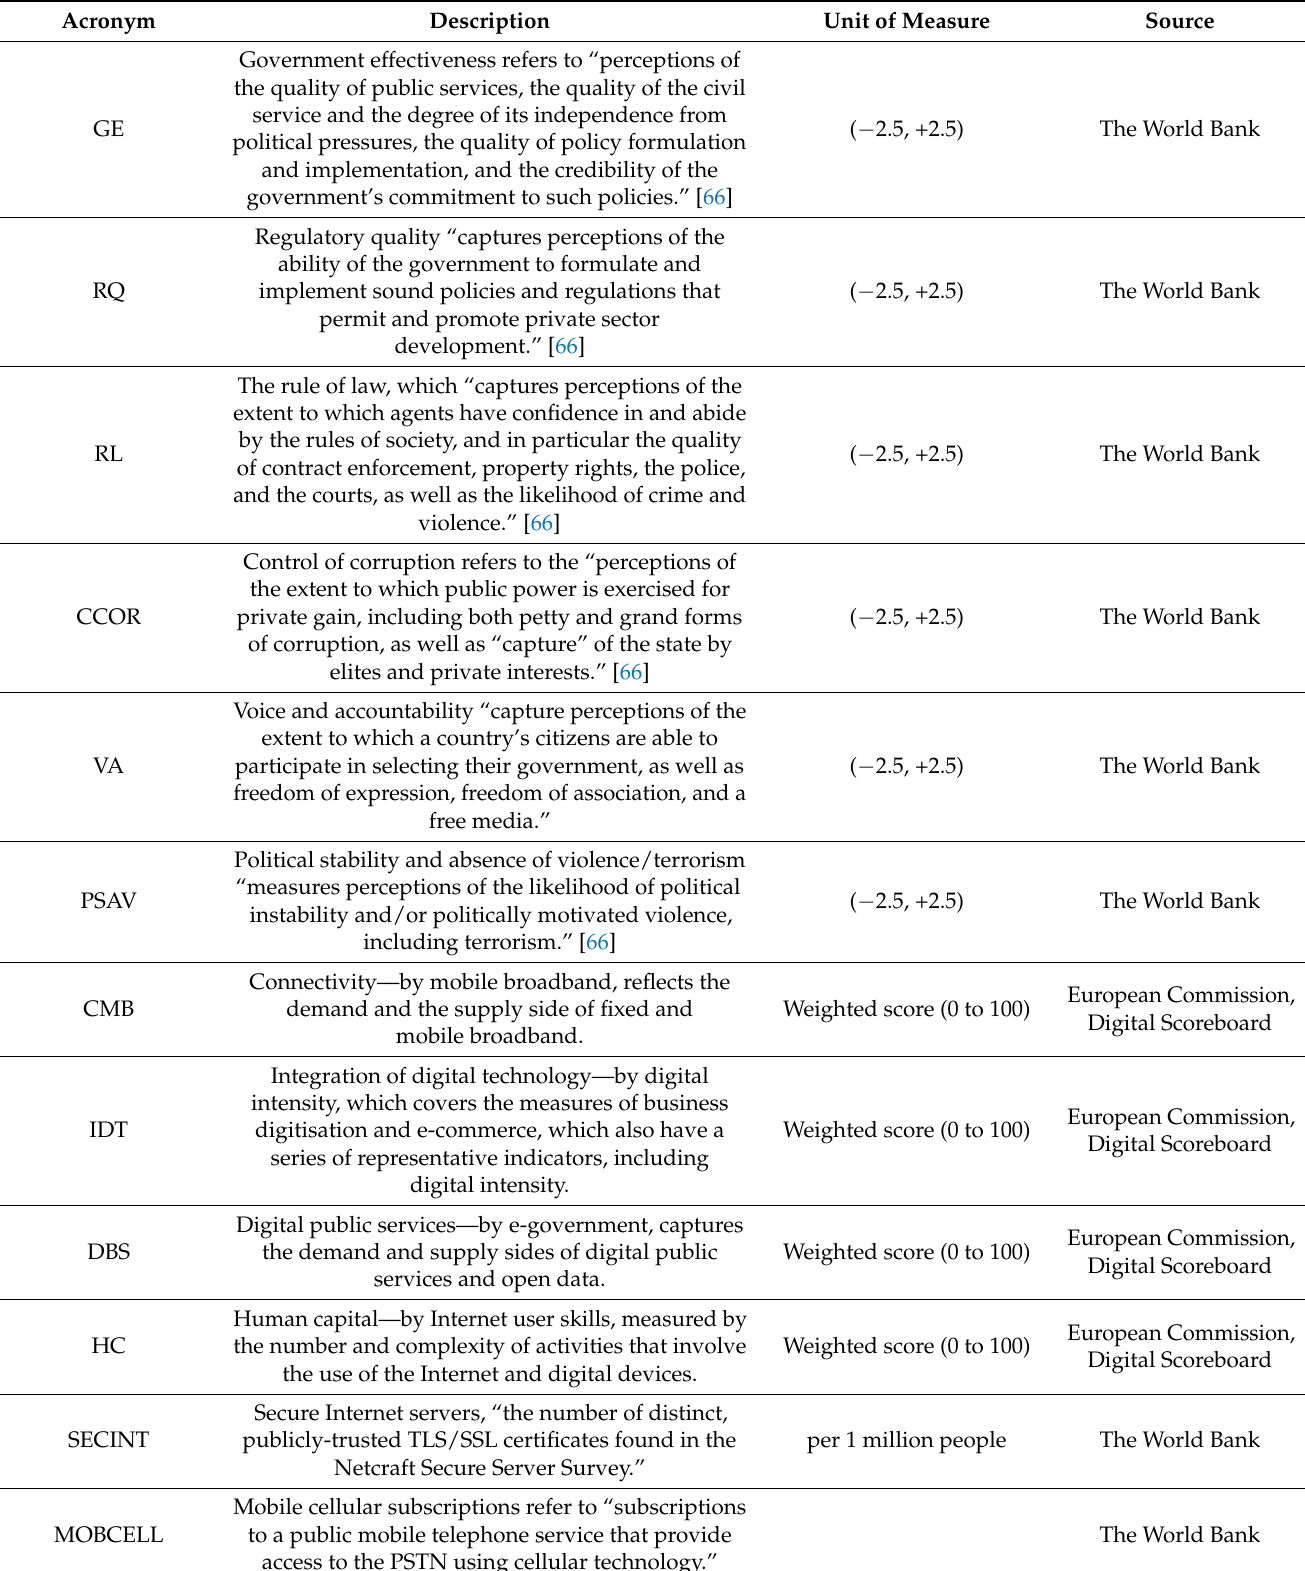
Table 2. Description of dataset